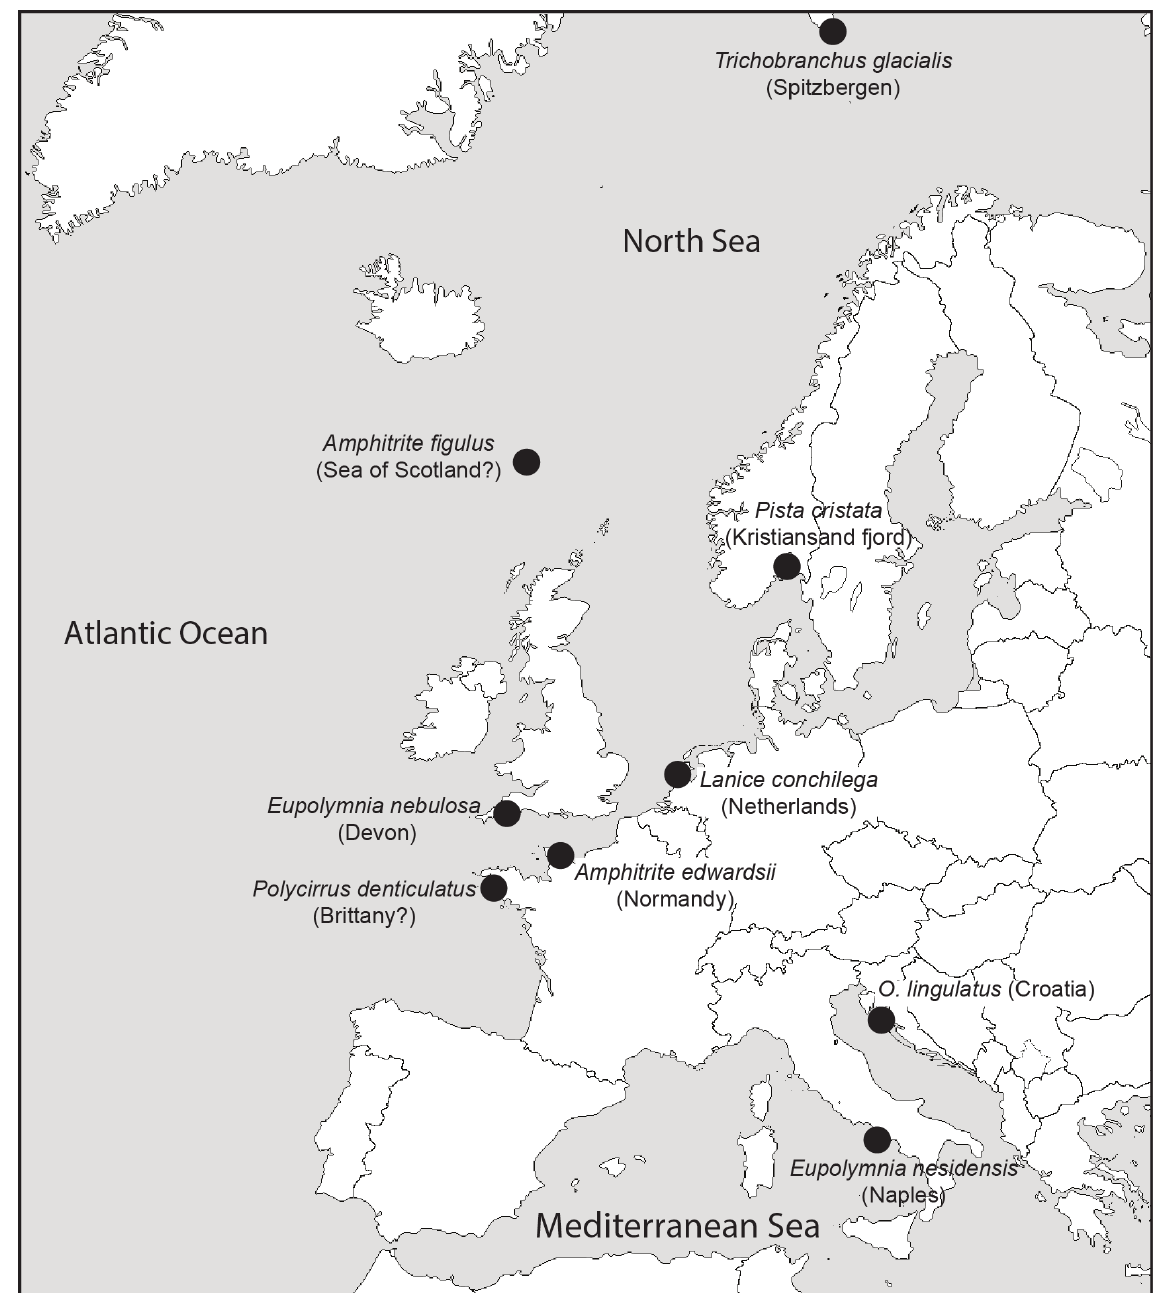
Fig. 9. Type localities of European species for which a neotype is